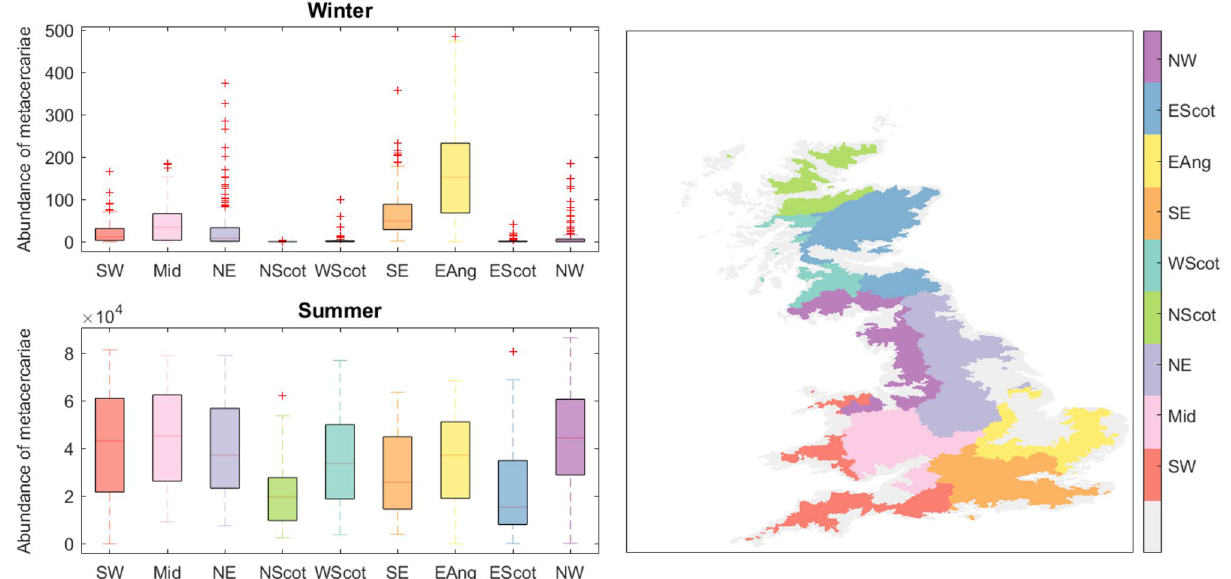
Figure 1. Seasonal abundance of metacercariae, i.e. disease risk simulated using HELF, on average over 2007–2015, across 9 UK regions. Boxplots represent variability in disease risk between catchments within regions. In the map (created using Matlab R2019a), ungauged catchments -i.e. with no hydrological data over the simulation period- are masked in grey. SW South West of England and West Wales, Mid rest of Wales